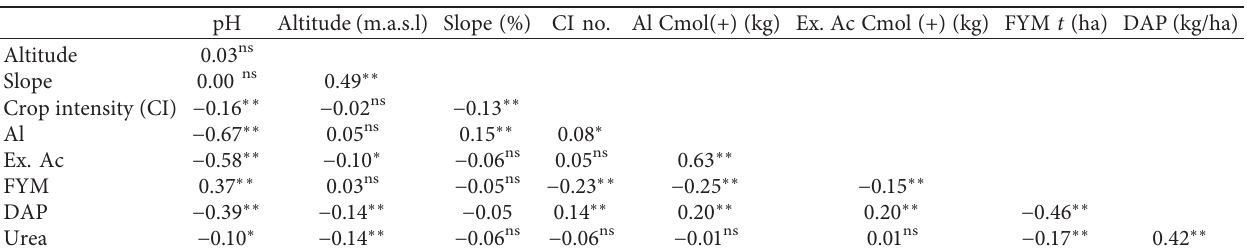
Figure 1: (a) Extent and spatial distribution of soil pH across the study site. (b) Extent and spatial distribution of exchangeable acidity (Cmol (+)/kg) across the study site. Table 2: Pearson’s correlation matrix between soil pH and different factors in crop lands ( N � 674).